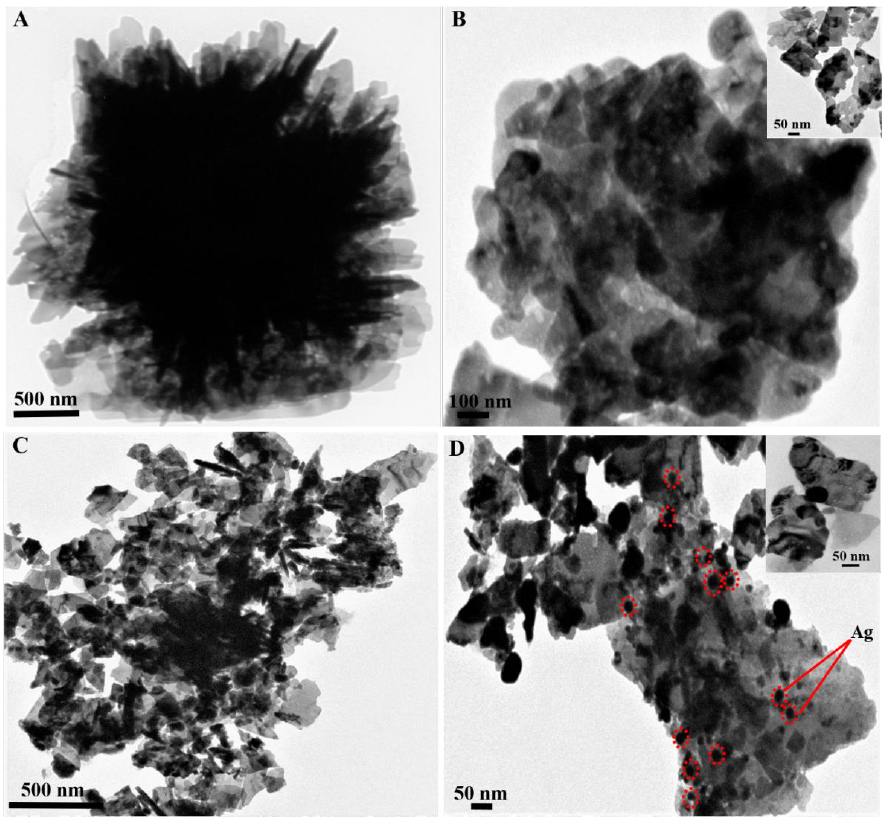
Figure 2. TEM images of 3D, hierarchical, nanosheet-based, flower-like ZnO ( A , B ) and Ag-3/ZnO ( C , D ). The red dot circle indicates Ag nanoparticles.